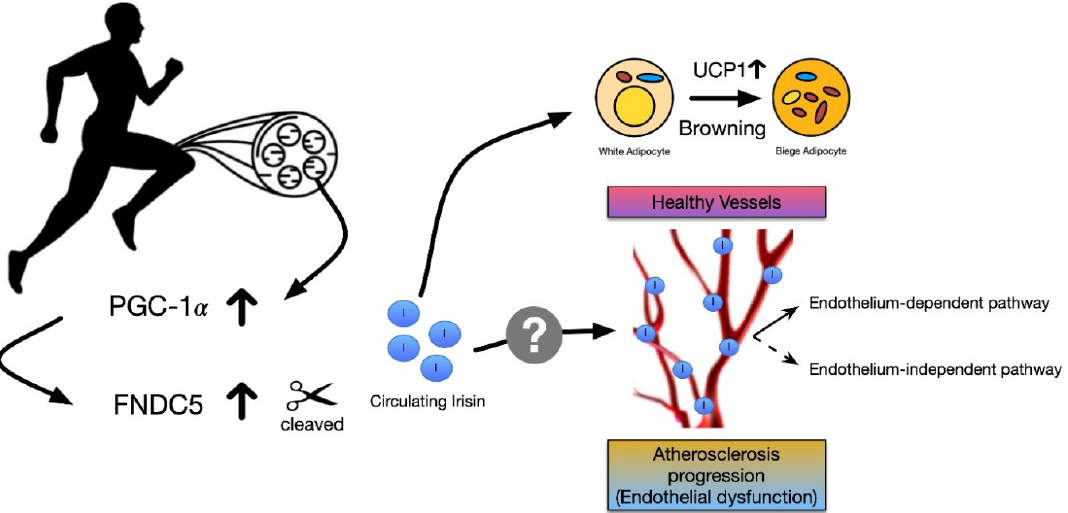
Figure 1. Potential molecular mechanisms underlying effects of irisin secreted by exercising skeletal muscle on vascular function and atherosclerosis. PGC-1 α , peroxisome proliferator-activated receptor-gamma coactivator-1 α ; FNDC5, fibronectin type III domain containing protein 5; UCP1, uncoupling protein 1.